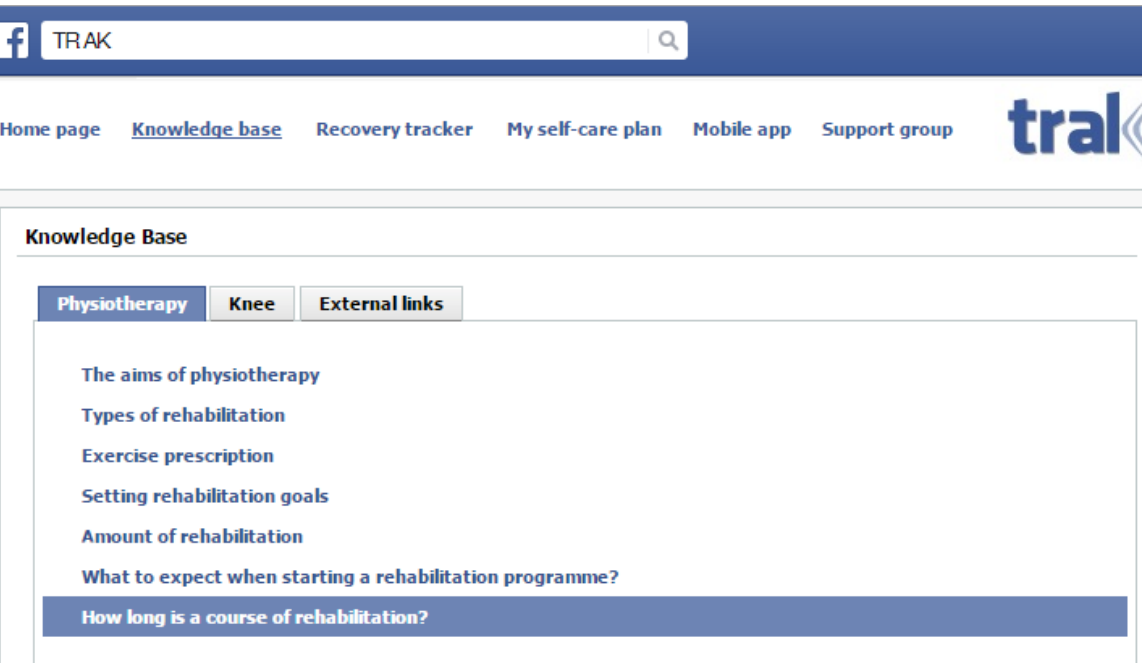
Figure 2. Knowledge base - Physiotherapy